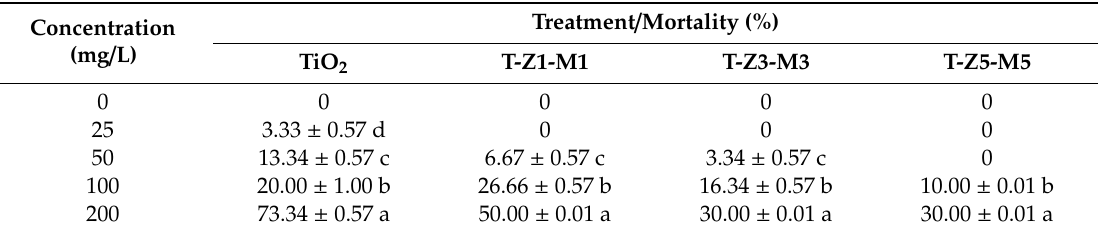
Table 2. Mortality values (%) of Artemia salina at di ff erent concentrations of TiO 2 and MONs. Concentration (mg / L)